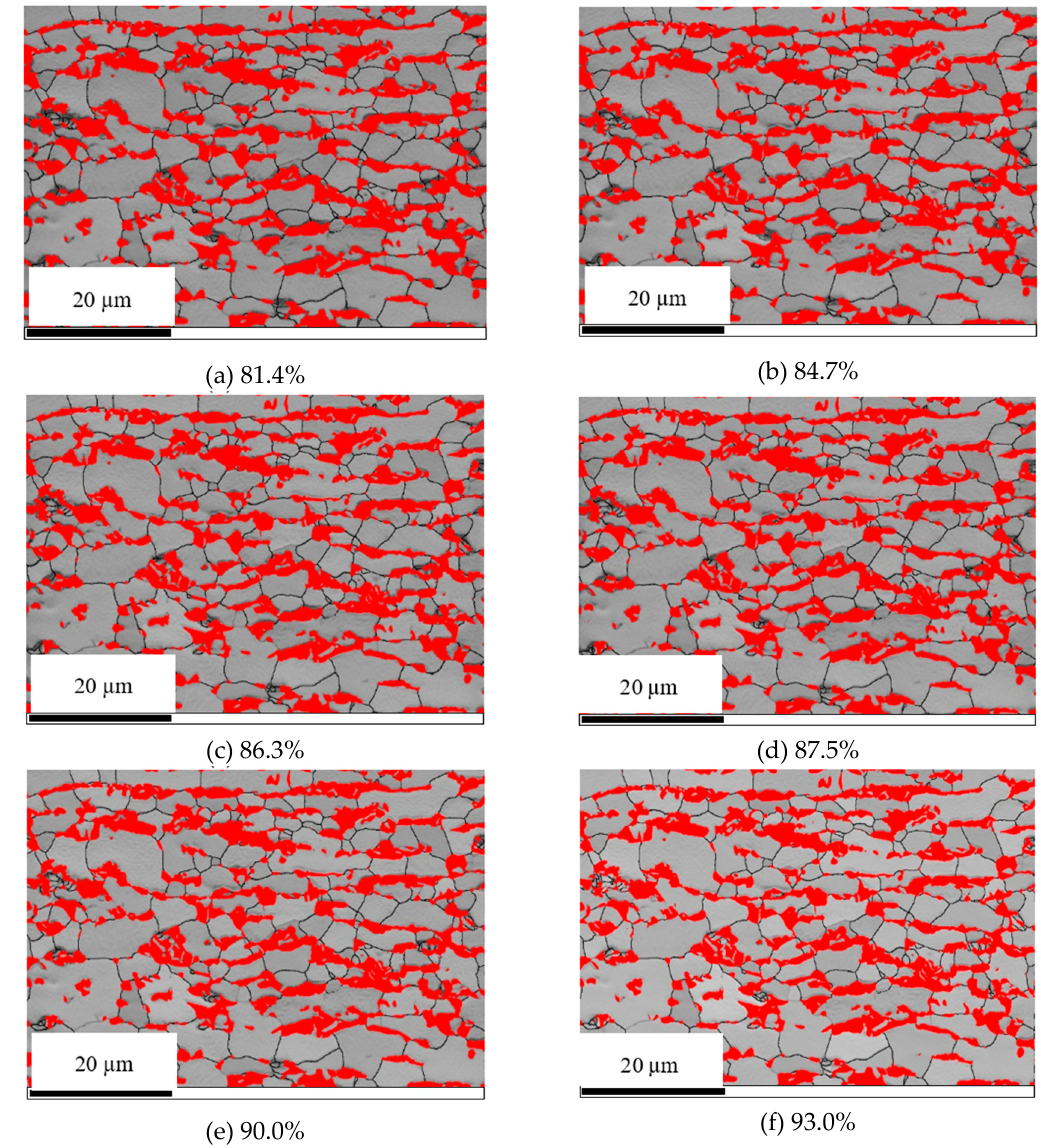
Figure 1. The morphology and distribution of retained austenite in TRIP780 steel at different indexing rates ( a : 81.4%; b : 84.7%; c : 86.3%; d : 87.5%; e : 90.0%; f : 93.0%).